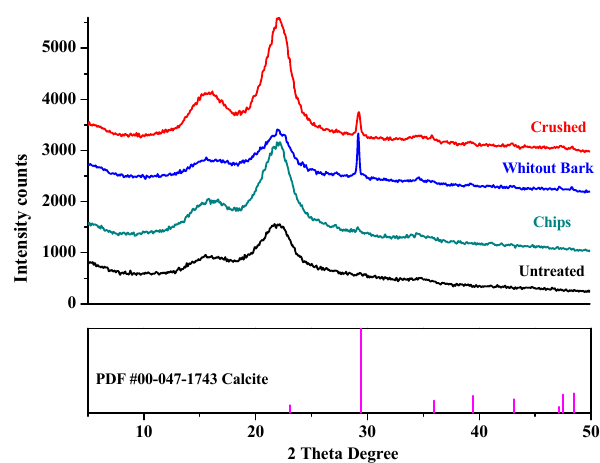
Figure 9. X-ray diffraction patterns of the untreated and Ca(OH) 2 -treated G. angustifolia samples, along with PDF #00-047-1743 calcite.